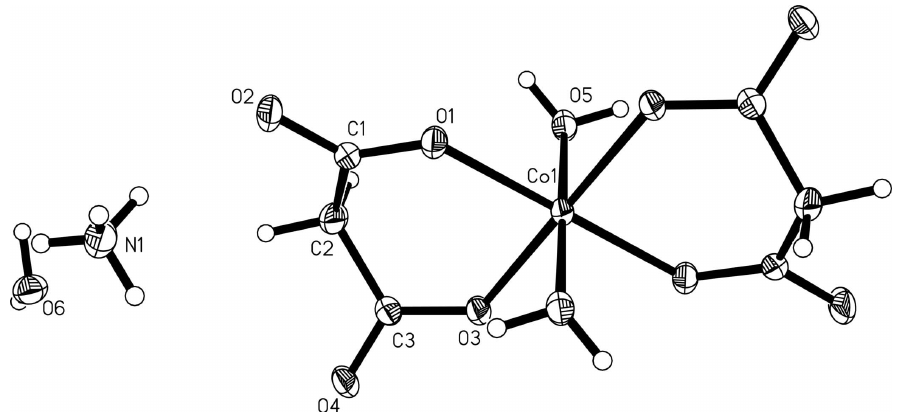
Figure 1 The structure of (I) expanded to show the coordination geometry of the Co atom which sits on a center of inversion; the unlabelled atoms are related by the symmetry operation - x , 2 - y , 1 - z . The figure shows 30% probability displacement ellipsoids and the atom-numbering scheme.